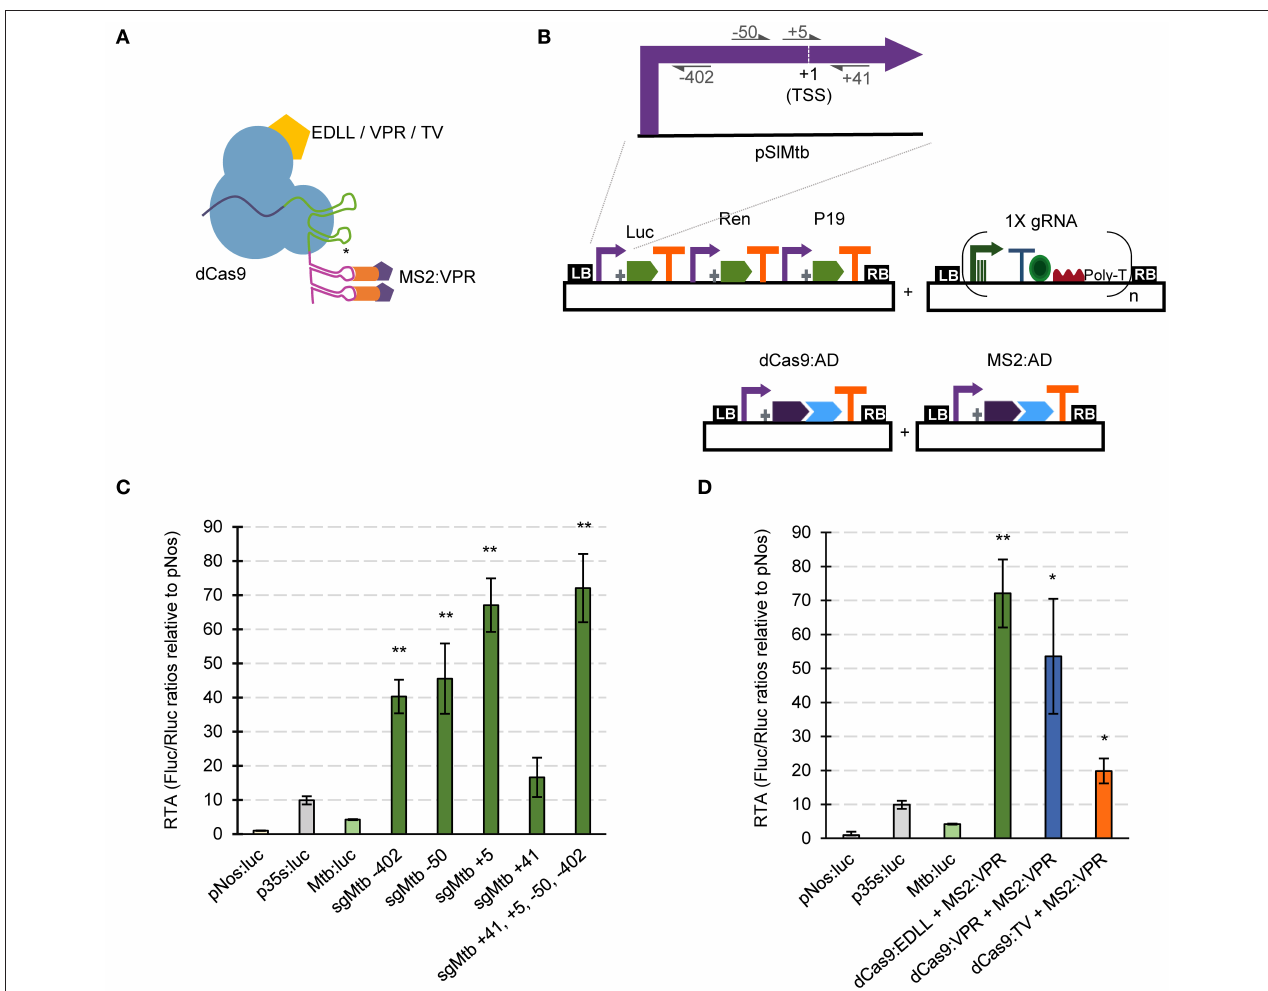
FIGURE 3 | dCas9-based positive regulation in transient expression in N. benthamiana . (A) Schematic representation of the GB plasmids co-infiltrated for evaluating dCas9-scRNA for activation of the Solanum lycopersicum Mtb promoter. (B) Schematic representation of the dCas9-scRNA complex that includes the dCas9 fused to different activation domains and a gRNA with a 3’ extension on its scaffold that serves as anchoring site for the MS2:VPR protein. (C) Relative transcriptional activities (RTA) of the tested gRNAs in combination with dCas9:EDLL-MS2:VPR (dCasEV2.1) and a luciferase reporter with the Mtb promoter. (D) Comparison of relative transcriptional activities (RTA) obtained using different dCas9:AD (activation domain) versions. The data of bar charts represent the mean average of relative transcriptional activities (RTA) determined as Fluc/Rluc ratios of each sample normalized to Fluc/Rluc ratios of GB1116. The error bars indicate the standard deviations of all biological replicates ( n = 3). The statistical analyses were performed using unpaired t -Test. Asterisks indicate significant differences with CaMV 35s:Luc with a * P -value < 0.05 and ** P -value <